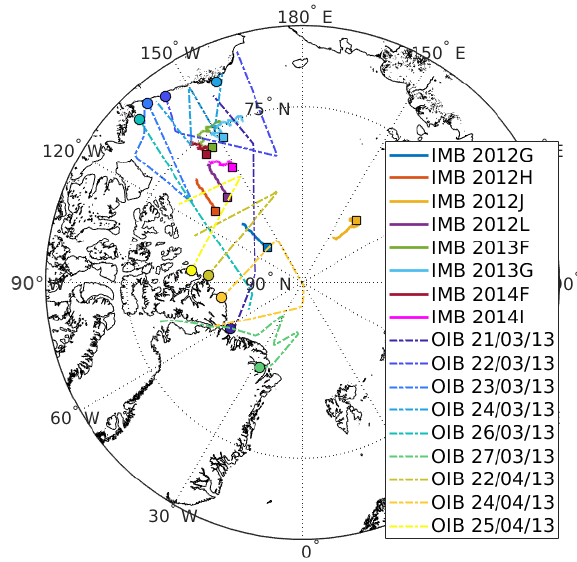
Figure 1. Ice mass balance buoy and Operation Ice Bridge (OIB) flight locations over Arctic sea ice. Squares indicate the position of IMBs on 1 December and circles indicate the starting points of the OIB